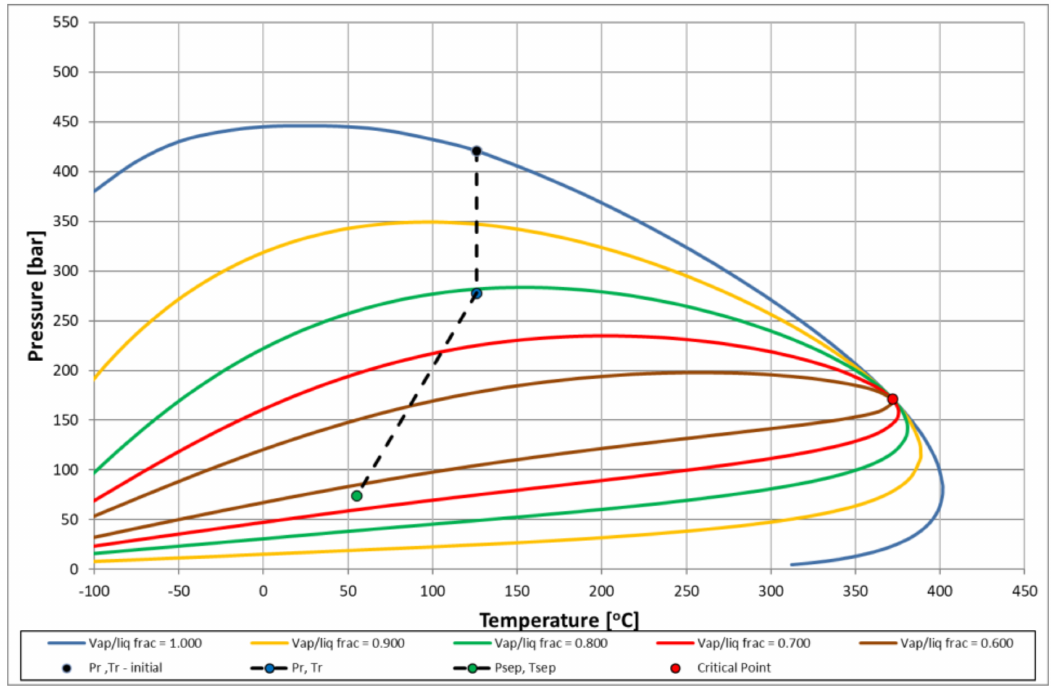
Figure 2. Phase diagram of reservoir